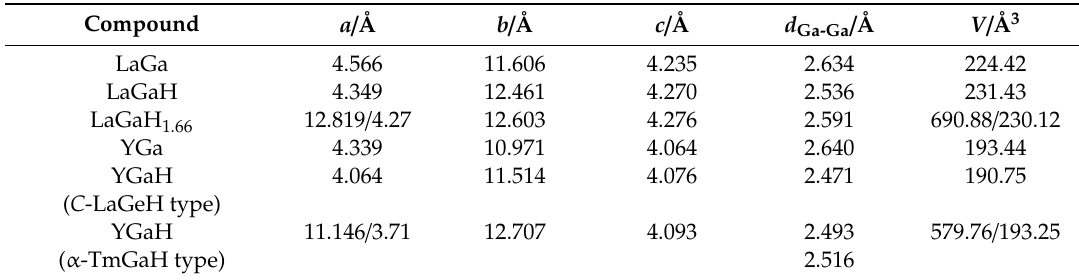
Table 3. Lattice parameter of the structure optimized compounds (superstructures are normalized to one CrB unit